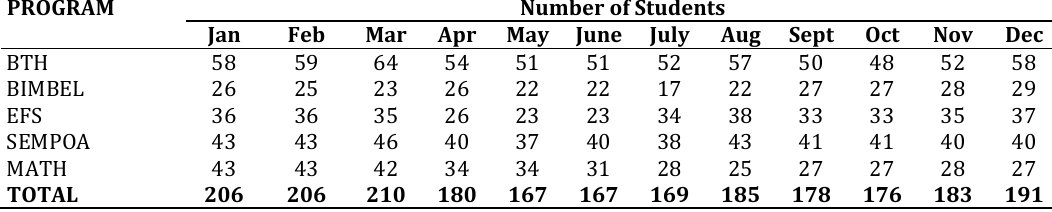
Table 1: Data of Elite Sang Tunas Kid Courses Denpasar students in 2018